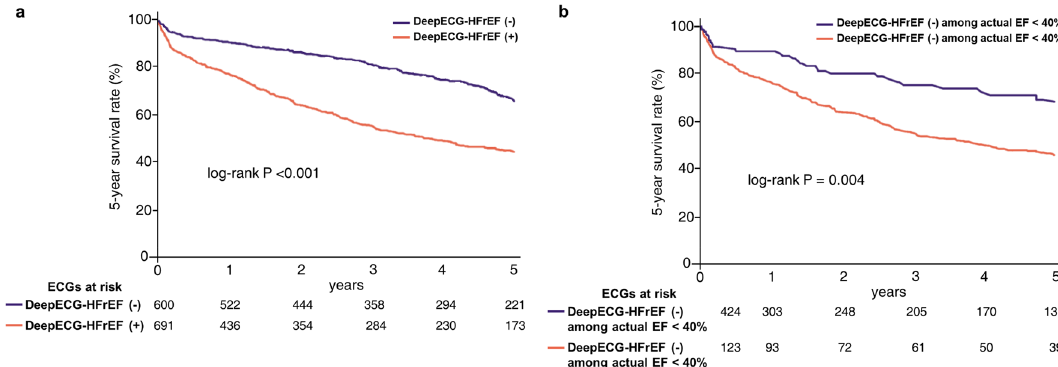
Figure 5. ( a ) Kaplan–Meier curve for mortality at 5-year follow up according to the DeepECG-HFrEF (Total ECGs = 1291) ( b ) Kaplan–Meier curve for mortality at 5-year follow up according to the DeepECG-HFrEF among patients with actual EF < 40%—The patients classified as DeepECG-HFrEF positive showed worse 5-year survival. ECG electrocardiogram; EF ejection